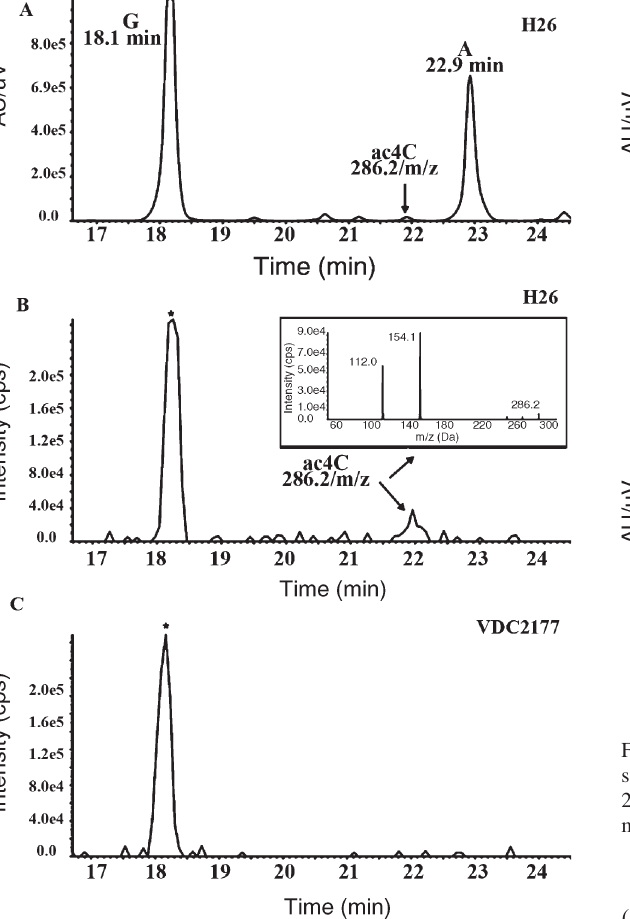
Figure 3. Analysis of LC-MS/MS tRNA extracted from H. volcanii strains showing the presence or absence of the ac 4 C peak on the UV trace at 254 nm for H26 (A) and the corresponding extraction ion chromatogram for the H26 and VDC2177 strains